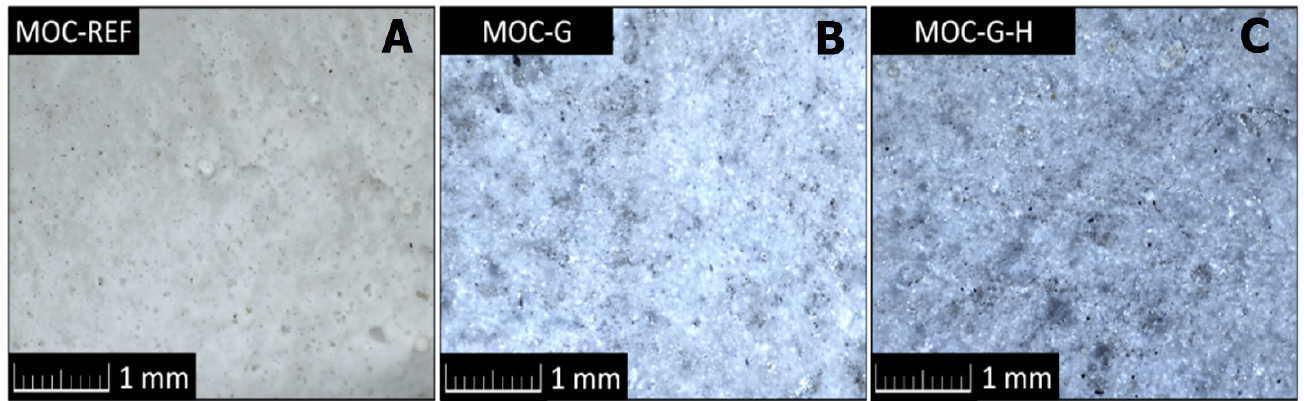
Figure 3. Optical micrographs of the prepared composites: ( A ) MOC-REF, ( B ) MOC-G and ( C ) MOC-G-H